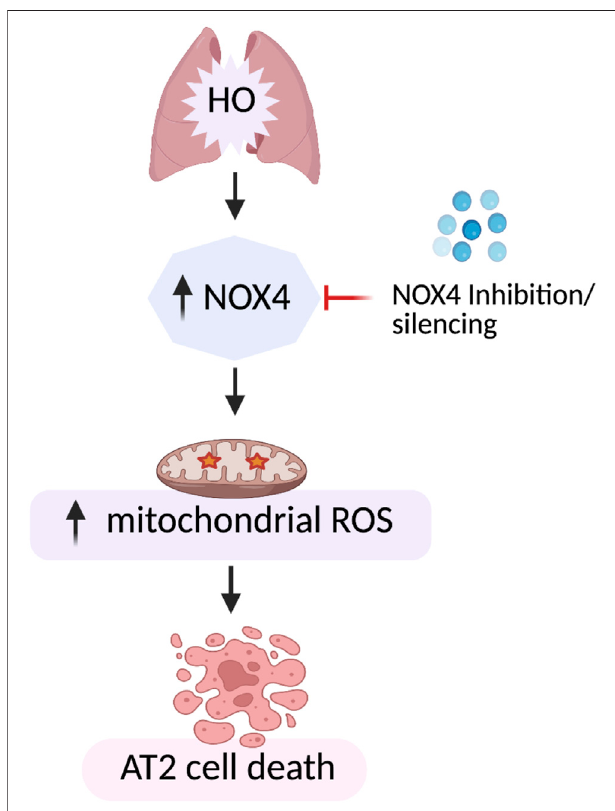
FIGURE12 | Model ofHO-induced apoptosis of lung epithelial cells. HO causes an increase in NOX4 expression leading to increased mt ROS production resultingin lungepithelialcell apoptosis. ThisHO-induced mtROS production and apoptosis was reduced by silencing NOX4 or mt ROS scavenging by